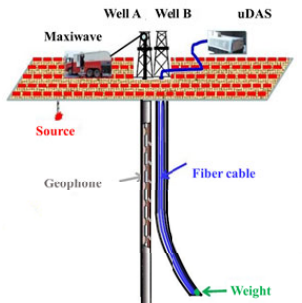
Fig. 27 Schematic diagram of dual-well VSP